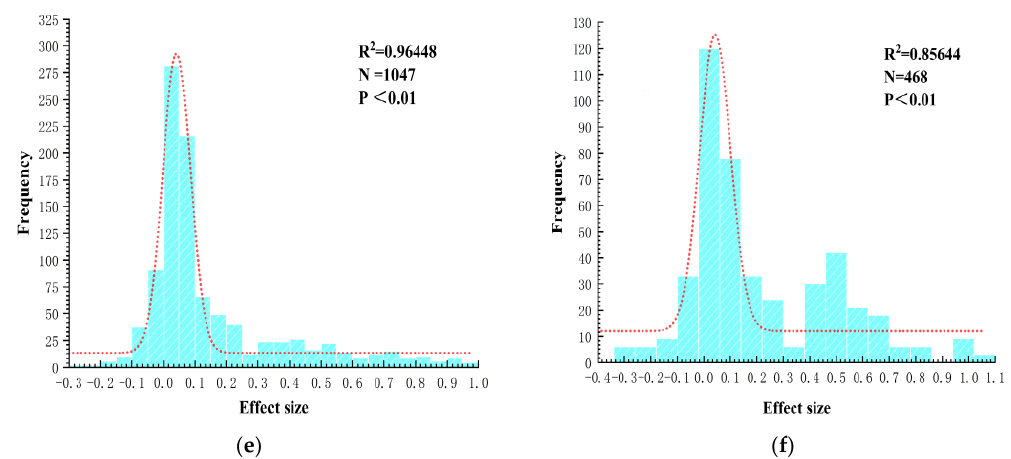
Figure 2. Frequency distribution of effect size, lnR, on alkaline-hydrolysable N ( a ), total N ( b ), soil organic C ( c ), the C:N ratio ( d ), yield ( e ), and the N accumulation ( f ) in paddy soils under total straw return conditions.